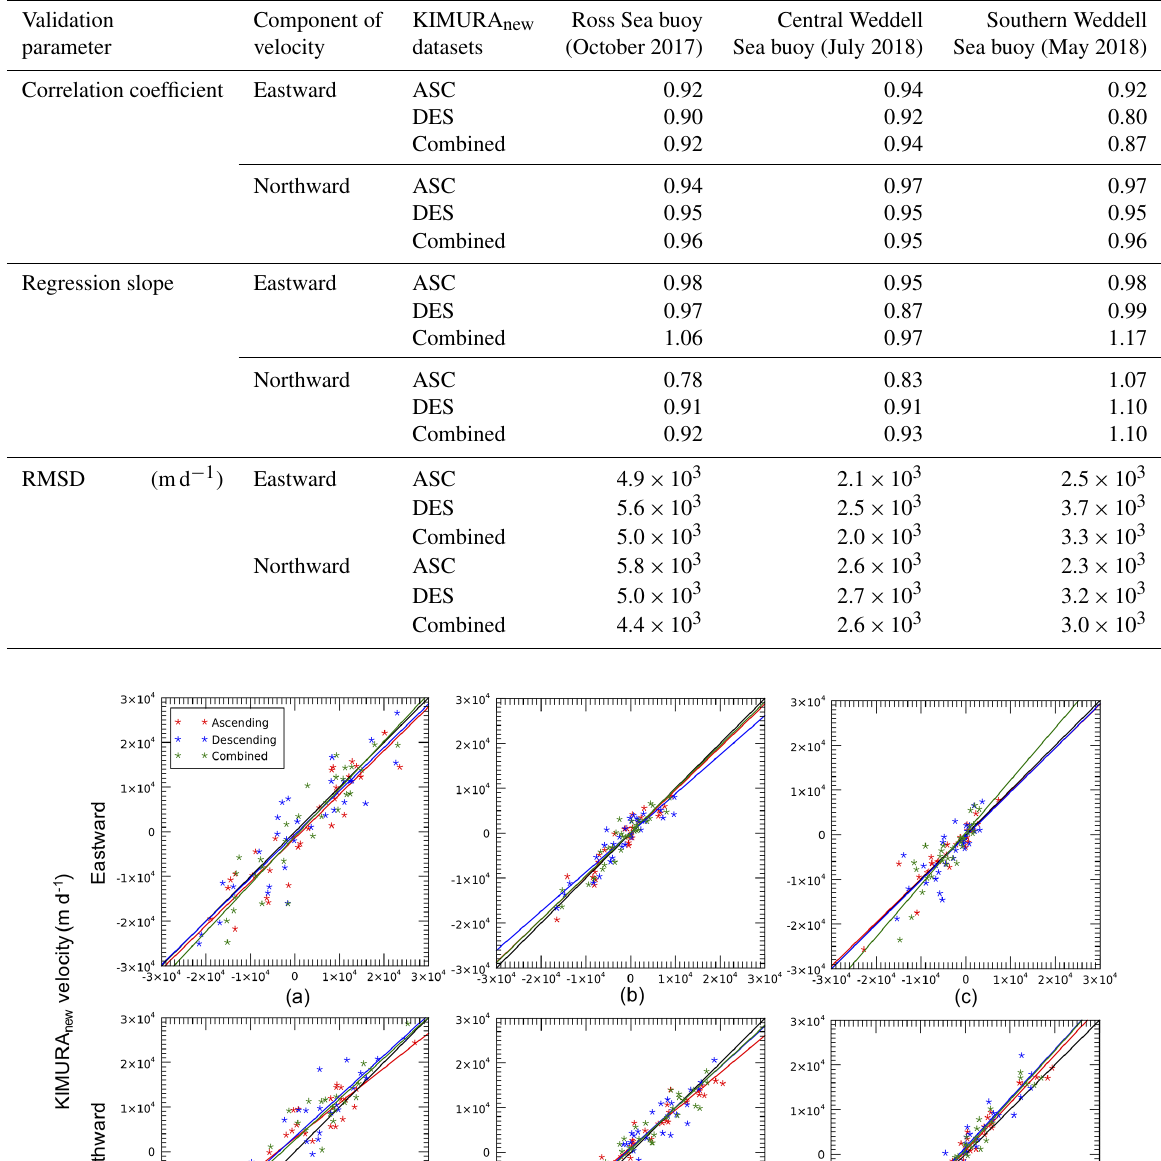
Table 2. Comparison between KIMURA new dataset and buoys.